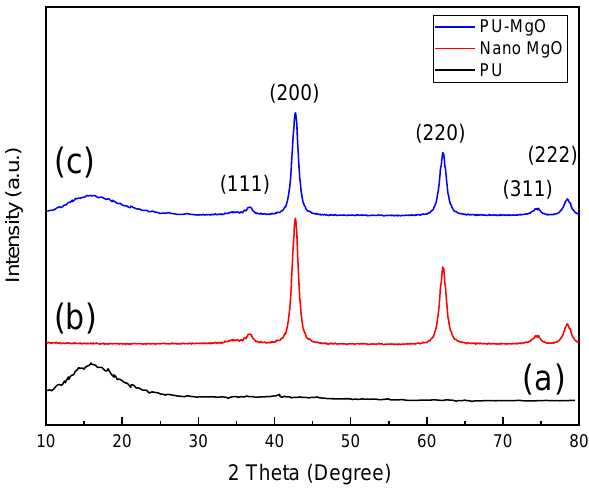
Figure 2. XRD patterns of ( a ) PU, ( b ) MgO, and ( c ) PU-MgO nanohybrids. The FTIR spectra of PU, MgO, and PU-MgO nanohybrids are shown in Figure 3. On the PU spectrum, the –CH 2 – stretching bands were found between 2926 and 2855 cm − 1 [48], while the urethane carbonyl band was seen at 1706 cm − 1 [1,46,49]. The C–N stretching bands, combined with those of the in-plane bending of N–H, were mostly seen at 1524 cm − 1 and 1449 cm − 1 , showing the reaction between the hydroxyl group and the isocyanate [46]. The characteristic C–O–C band was seen at 1074 cm − 1 [46,50]. In the MgO FTIR spectrum, O–H bond vibrations of the hydroxy group were observed in the broadband near 3696 cm − 1 . MgO nanoparticles were indicated by the peak at 421 cm − 1 [51,52]. At 1386 cm − 1 , vibrations associated with C–H bending were detected [52]. The peaks seen at 1741 cm −1 and 1644 cm −1 indicated the presence of strong C=O and C=C stretching, while the peak at 3261 cm − 1 showed the existence of weak, broad O-H bond stretching [46]. In the spectrum of the PU-MgO nanohybrids, peaks related to PU and MgO were observed.